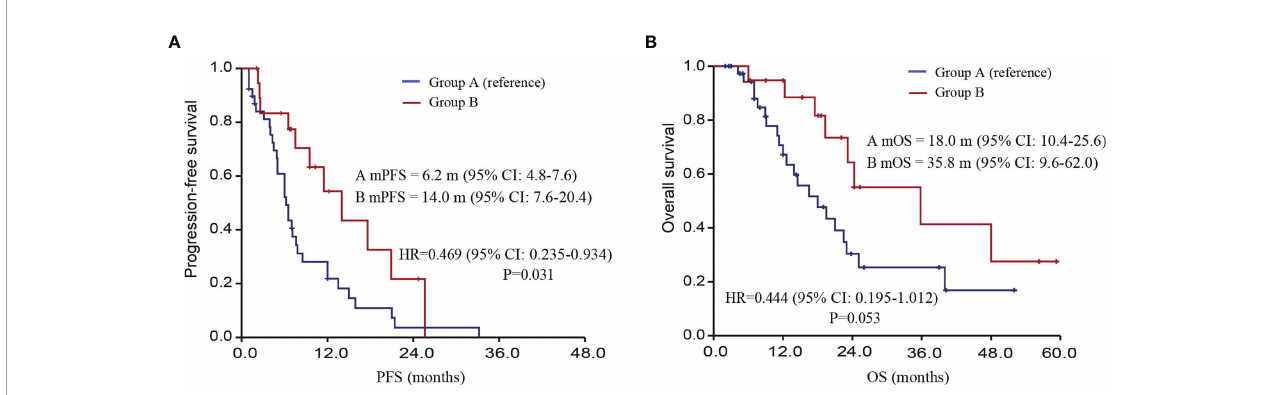
FIGURE 3 | Follow-up information of different treatment options after systemic treatment. [ (A) PFS of patients; (B) OS of patients; PFS, progression-free survival; OS,